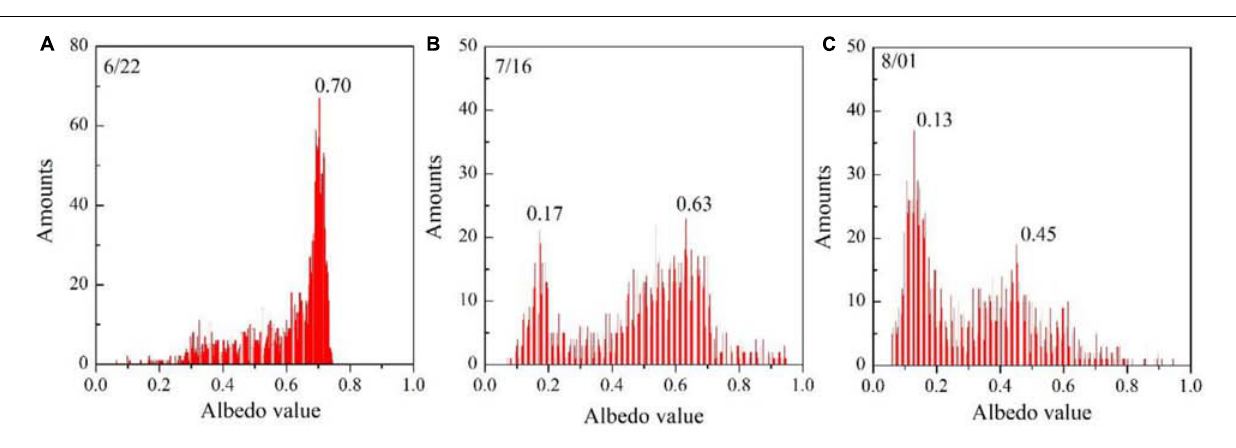
FIGURE 5 | The frequency distribution of the surface albedo over the whole Urumqi Glacier No. 1 in the 2006 ablation